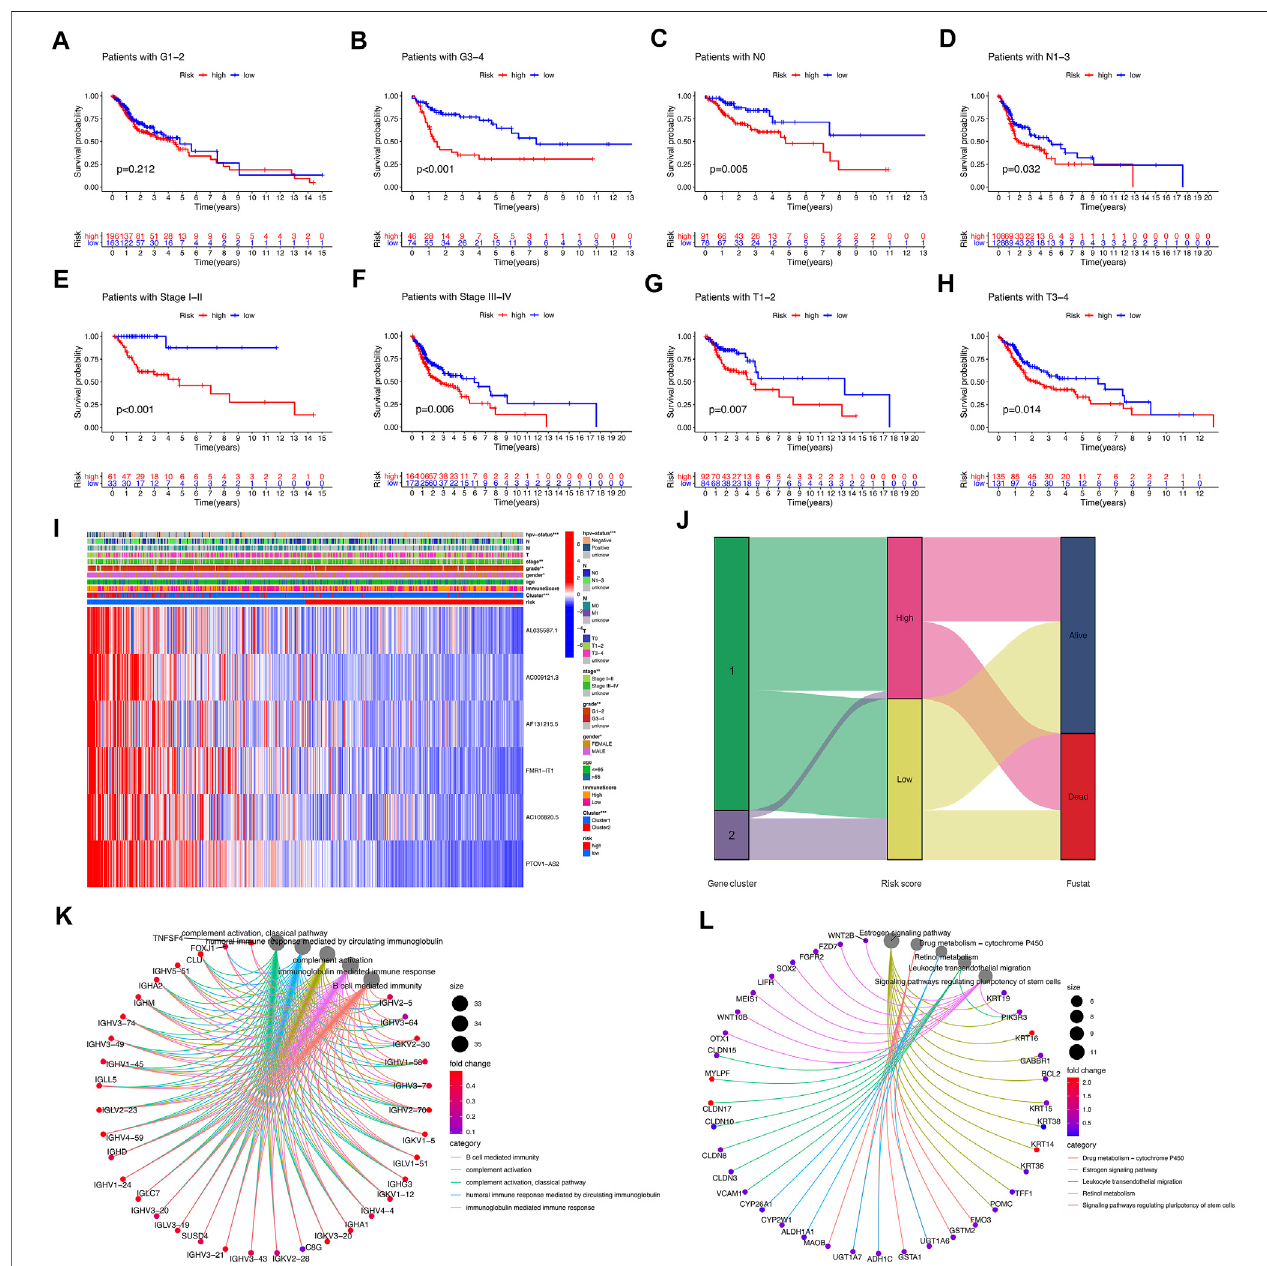
FIGURE 5 | Correlation of risk model subgroups with overall survival and different clinical characteristics in TCGA-HNSCC database. (A – H) Kaplan – Meier curve of the overall survival of patients with different clinical traits in high-risk group and low-risk group. (I) Heatmap of association between expression levels of six prognosis lncRNAs and clinicopathological features in TCGA database. (J) The sankey diagram of the relationship among the cluster, risk score and survival state. (K,L) GO and KEGG analysis.